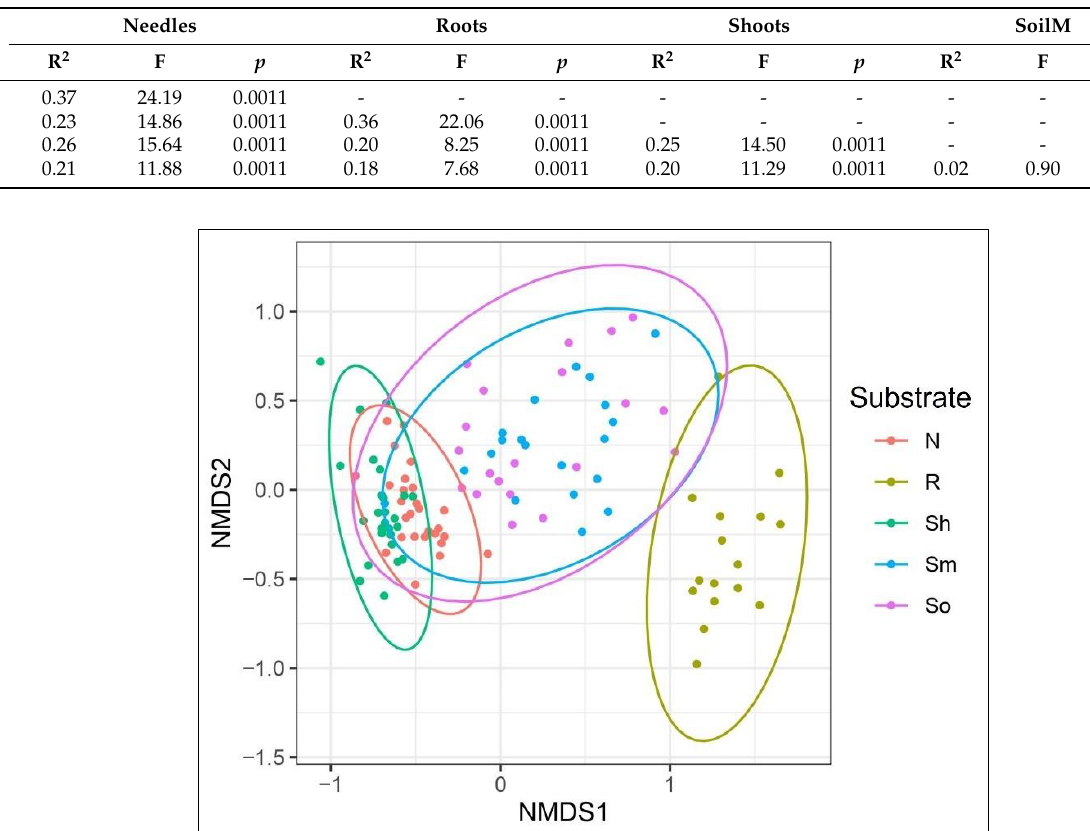
Figure 9. Non-metric multidimensional scaling (NMDS) of fungal communities associated with different substrates (N — needles, R — roots, Sh — shoots, Sm — mineral soil, and So — organic soil) of Pinus sylvestris .